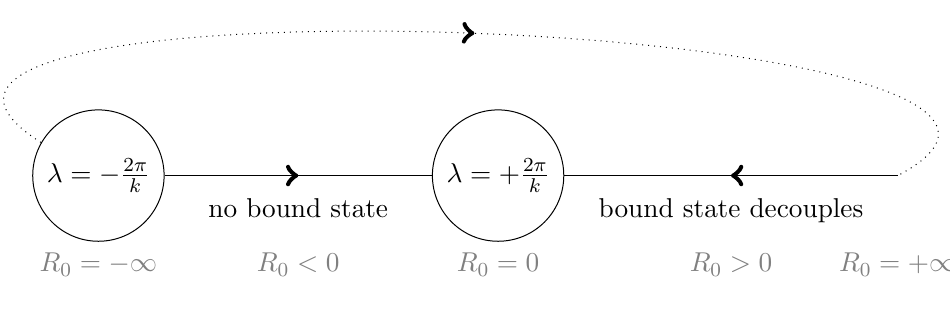
Figure 6 . Cartoon of the RG flow of the anyonic theory.